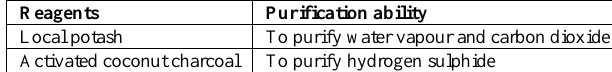
Table 3. Purification ability of the reagent used